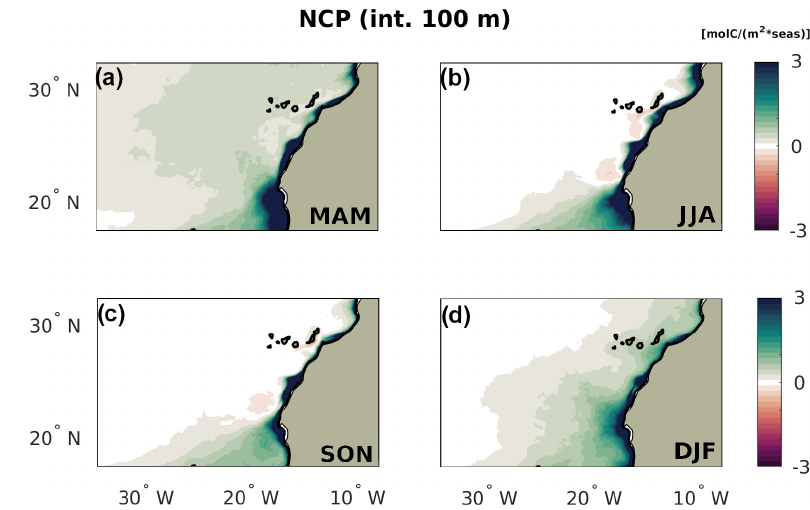
Figure B3. Total NCP by season integrated across the euphotic layer (100m depth).